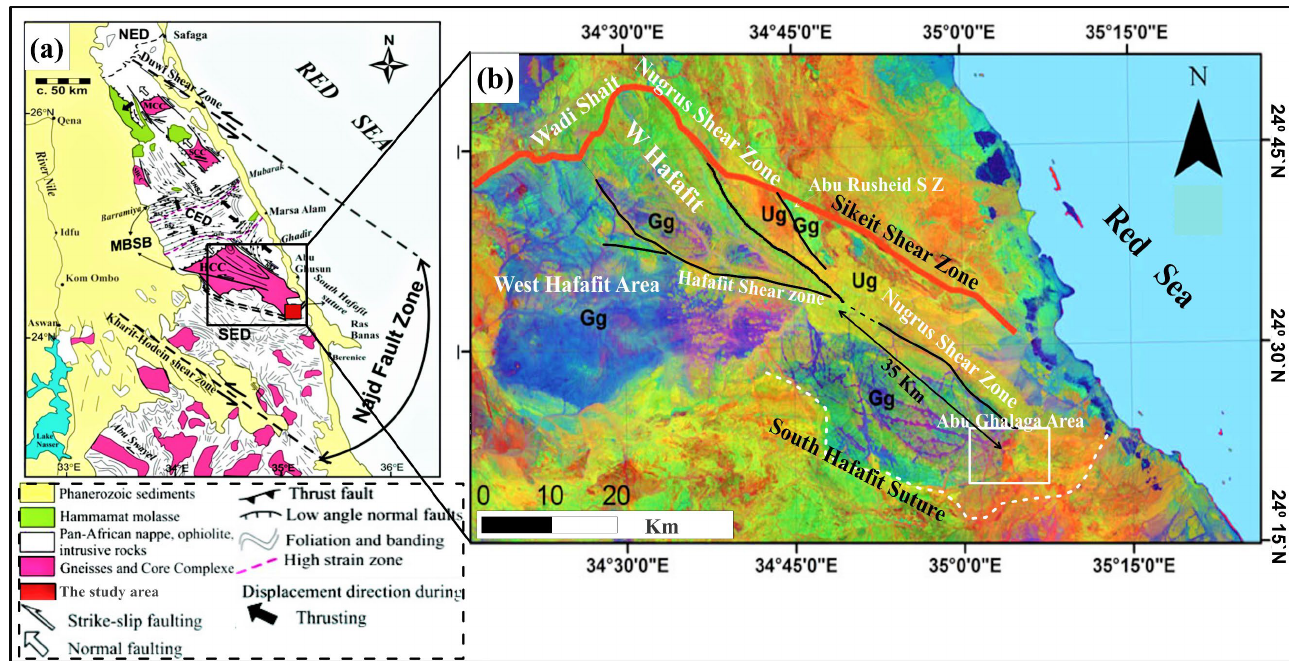
Figure 2. ( a ) Major structures in the central eastern desert (CED) and south-eastern desert (SED).